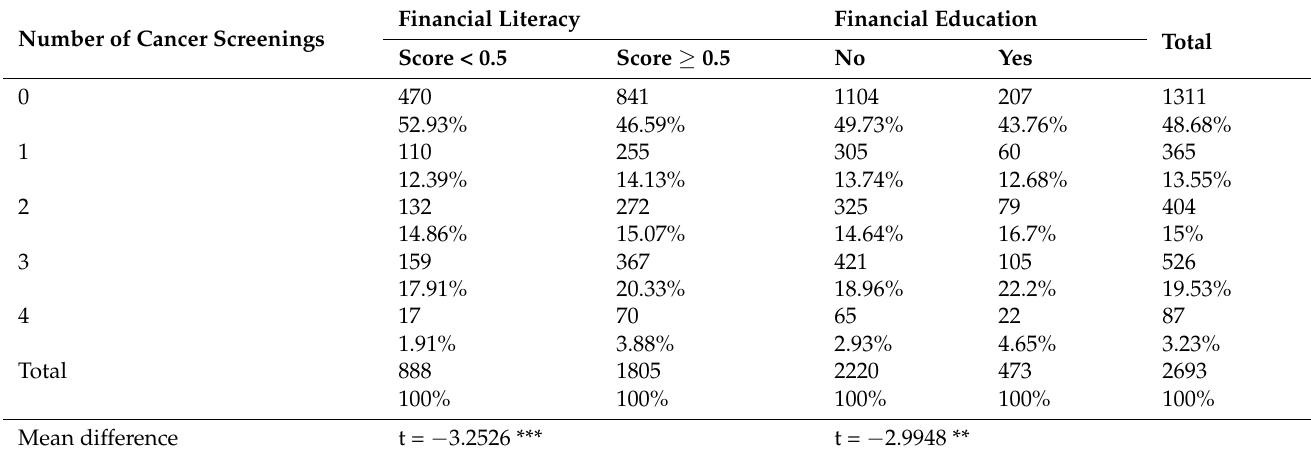
Table 6. Distribution of the number of cancer screenings by financial literacy and financial educa- tion